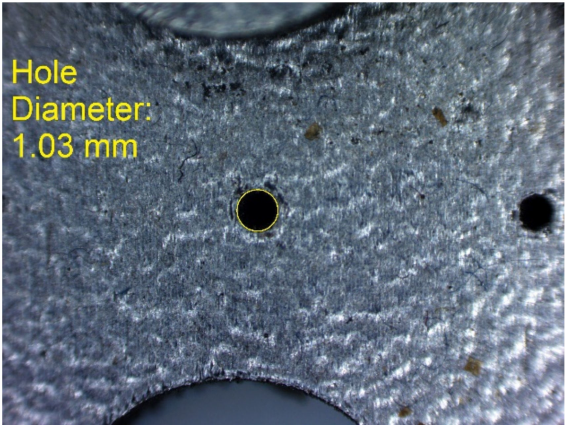
Figure 13. Measurement result for cylindrical holes and solids made in the DMLS technology: hole with a nominal diameter D m = Ø1 mm (D m1 = 1.03